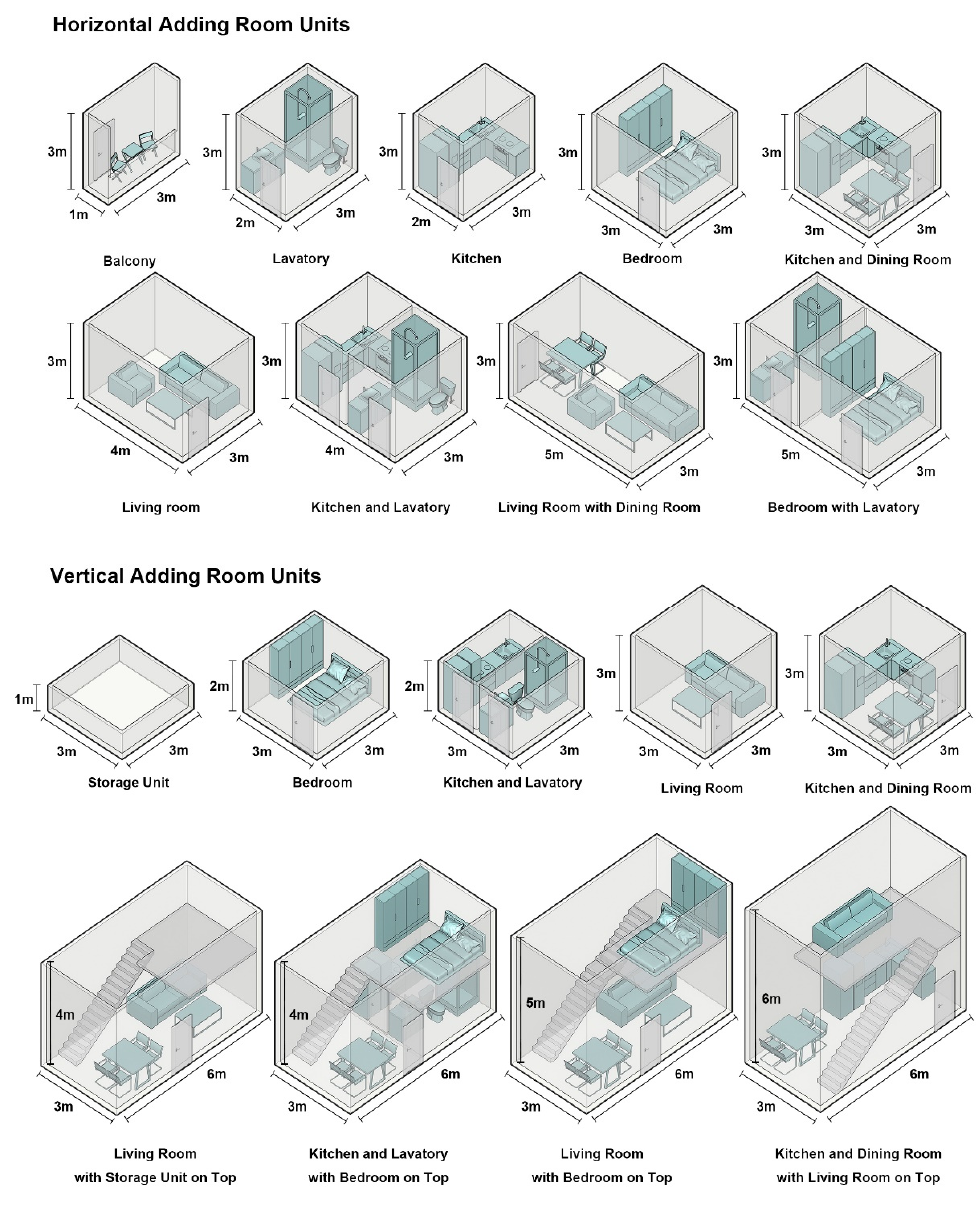
Figure 4. Functional module unit of the extra attached